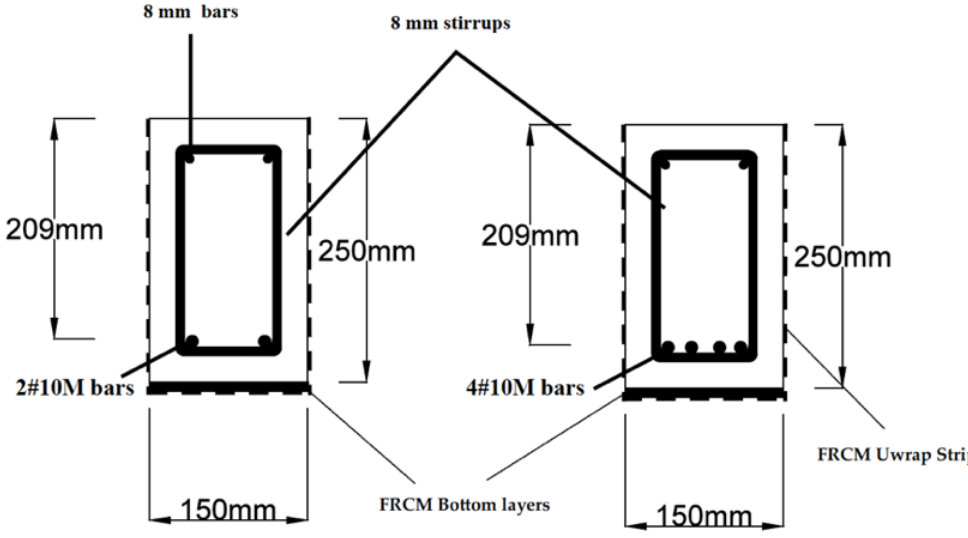
Figure 6. Test specimen details.